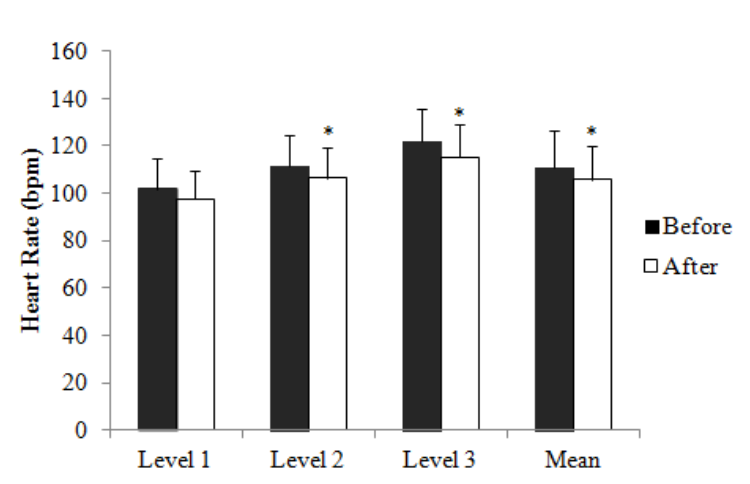
CI, confidence interval for the di ff erence between means.